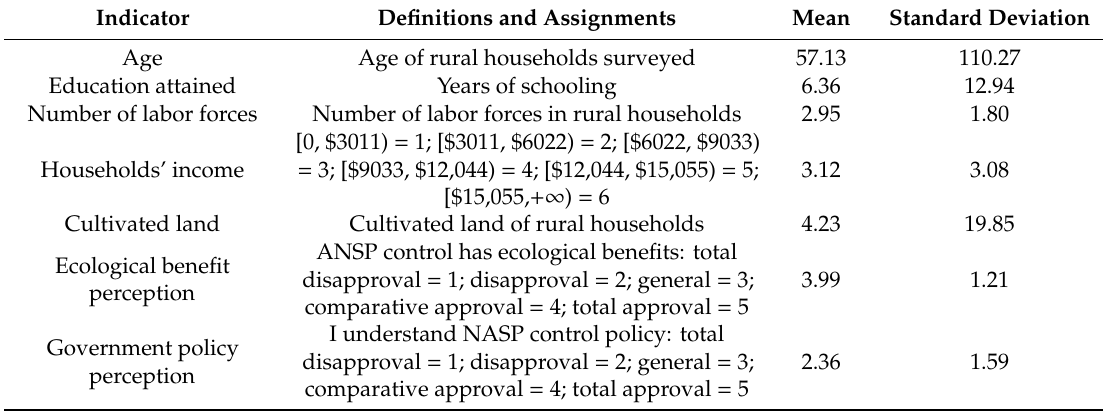
Table 2. Statistical description of sample